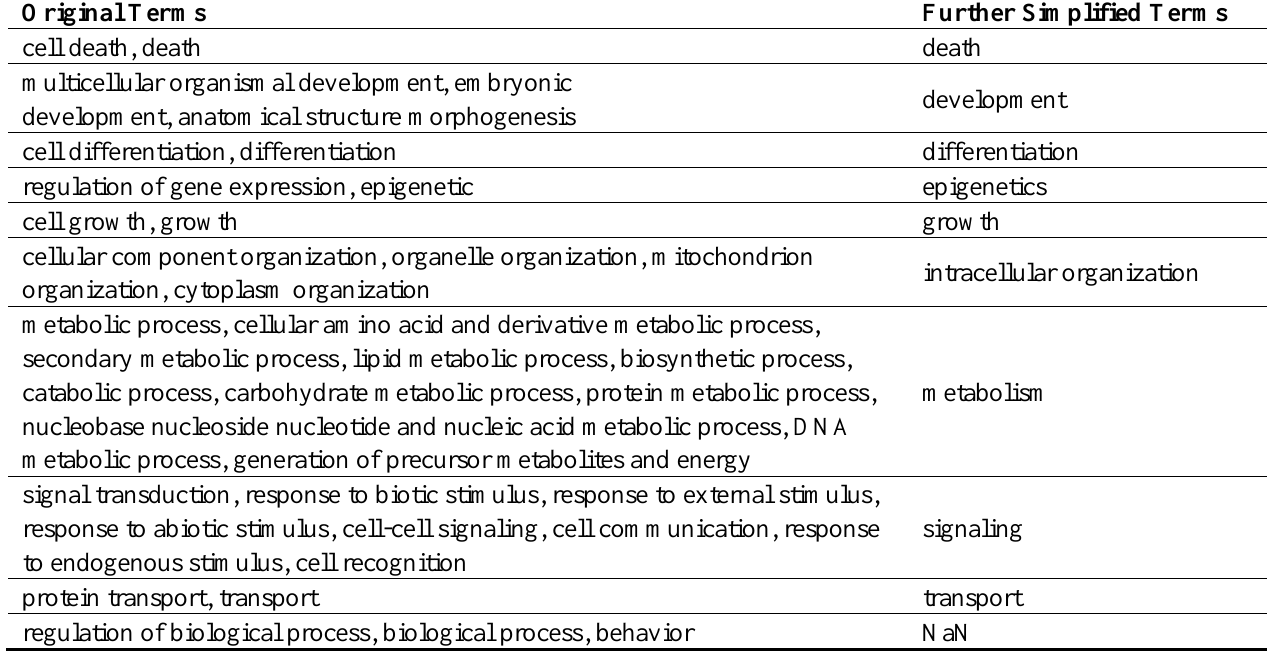
Table 6. Simplification of the gene ontology slim generic